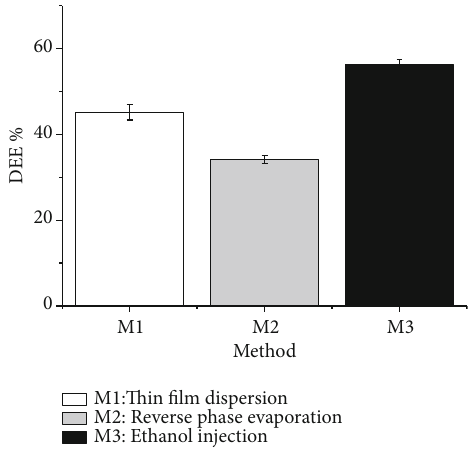
Figure 3: DEE results under di ff erent preparation methods ( n = 3 , x ± s